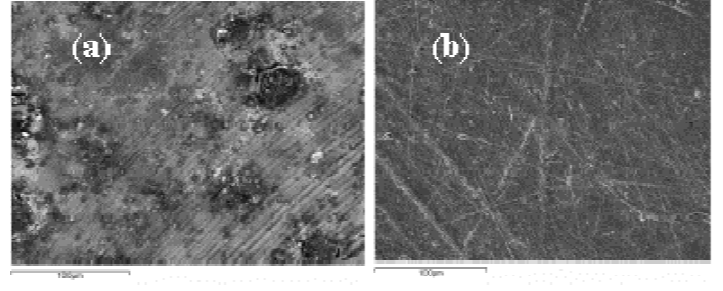
Figure 6. Scanning electron micrographs obtained for an ss-DNA-EDC/NHSS-MPA-AuE before (a) and after (b) accumulation of MB. Immobilization conditions: 2.5 µg DNA, 24 h drying time. = 1 min, open Accumulation conditions (b): [MB] = 75 µ M, t acc